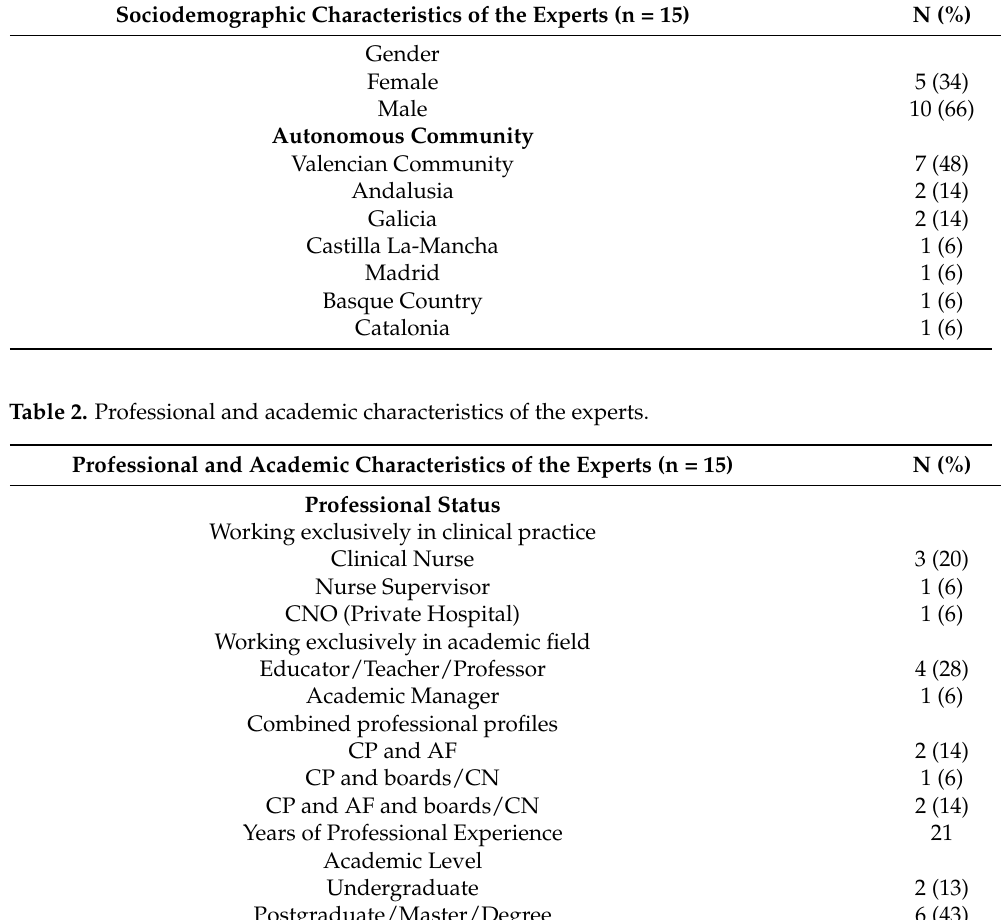
Table 1. Sociodemographic characteristics of the experts.